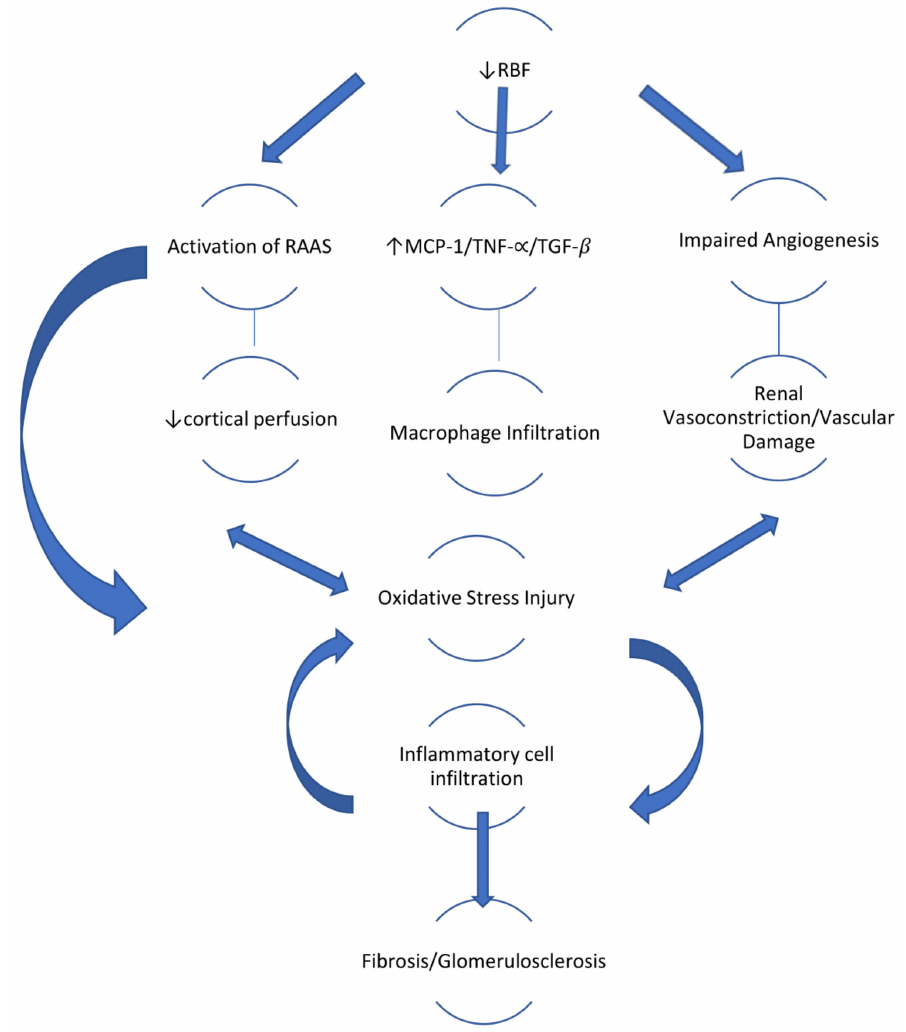
Figure 1. Role of oxidative stress in the pathophysiology of ischaemic nephropathy. Much of our recent understanding has been derived from pig models. Following ex- perimental induction of RAS, levels of prostaglandin G2 α -isoprostrane (a systemic marker of oxidative stress) along with other markers of oxidative stress are markedly increased and correlate well with both renin activity and arterial pressure. Even when renin activity re- turns to normal, arterial pressure remains elevated along with isoprostrane levels, possibly due to a prolonged effect of angiotension II within the ischaemic tissue, demonstrating a correlation between renovascular hypertension and oxidative stress [17]. As stenotic lesions progress leading to more hypoperfusion of the renal cortex, and hence more oxidative stress, this in turn leads to inflammation and tubular injury in the affected kidney, leading to irreversible injury, fibrosis and ultimately progression of renal impairment to ESKD [18]. This persistent inflammation and related oxidative stress likely explain the failures of revas- cularisation to have a marked effect on estimated Glomerular Filtration Rate (eGFR) and blood pressure in the majority of patients with atherosclerotic RAS. Human studies have shown improved renal blood flow and cortical prefusion post successful revascularisation, but, despite this, markers of renal inflammation such as neutrophil gelatinase-associated lipocalin (NGAL), MCP-1 and TNF- α remain elevated and are not altered by restoration of blood flow or tissue oxygenation [19]. MCP-1 in particular has a key role as a